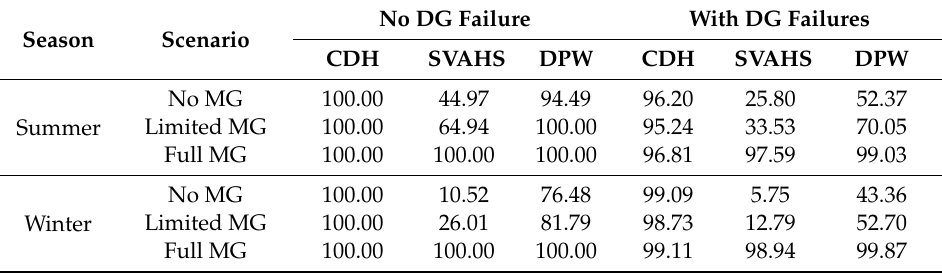
Figure 16. Survival rate and fuel consumption of the system without PV arrays at CDH. Table 13. Mean Survival rates of the system without CDH PV in 3 days outages. Three Days Outages